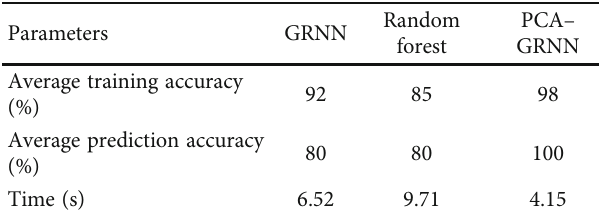
Table 7: Comparison of the evaluation results of each